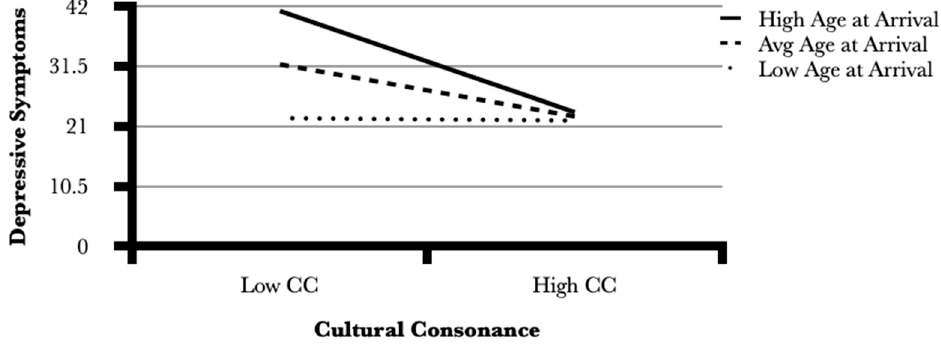
Figure 2. Interaction effect of age at arrival in U.S. and cultural consonance on depressive symptoms.